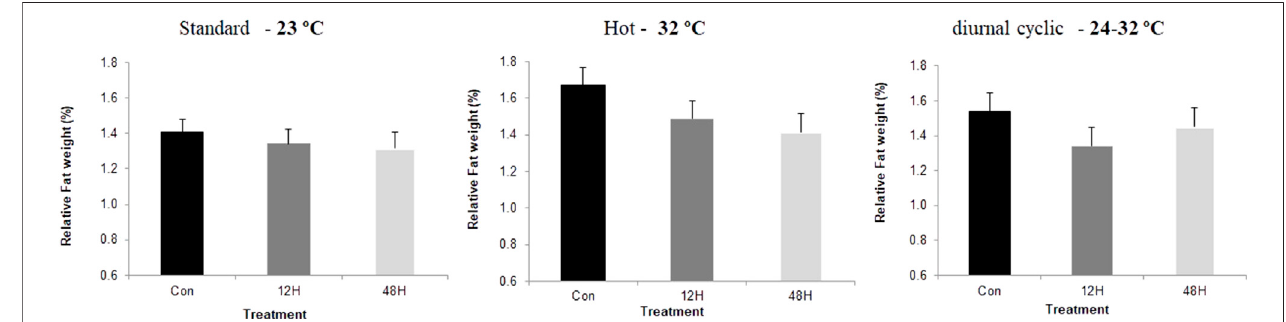
FIGURE 2 | Relative abdominal fat pad (% fi nal body weight at 42 day), of broilers that were exposed to different hypoxia regimes (12H and 48H) during embryonic development and then raised under different environmental ambient temperatures (cold, standard, hot, and diurnal cyclic ambient temperature).